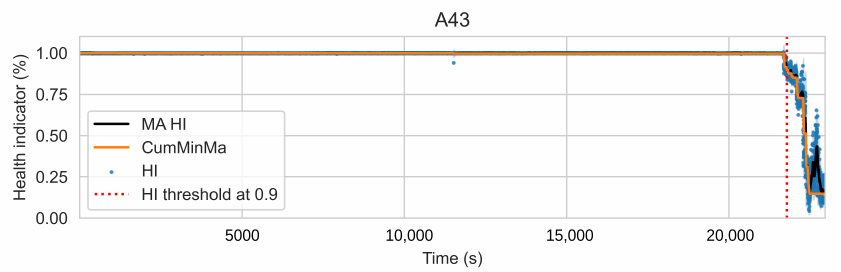
Figure 15. Health index predictions for bearing A43. Intervals as the +/ − 1 running standard deviation.